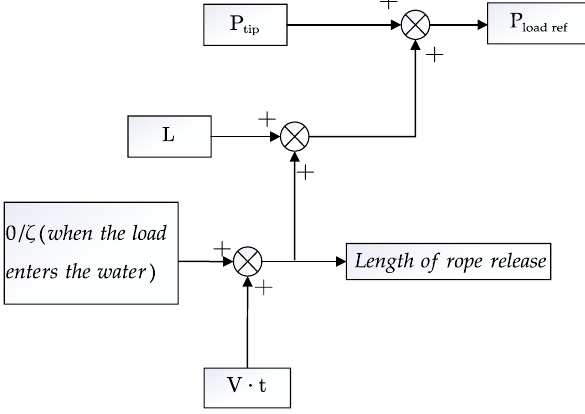
Figure A2. The position setting module.